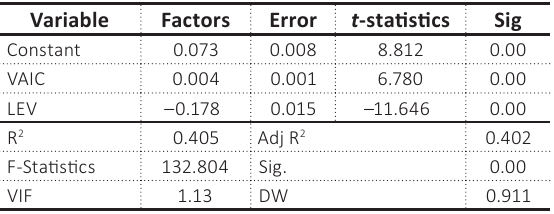
Table 5. The first model (Big companies)